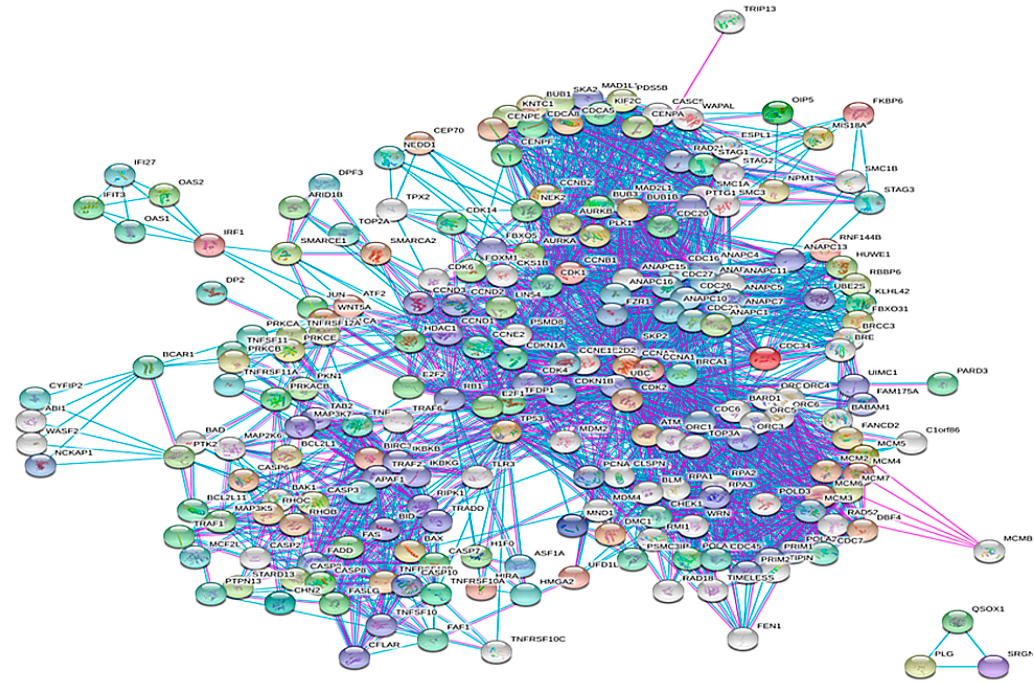
Figure 9. Protein–protein interaction network (PPIN) of final seed proteins.